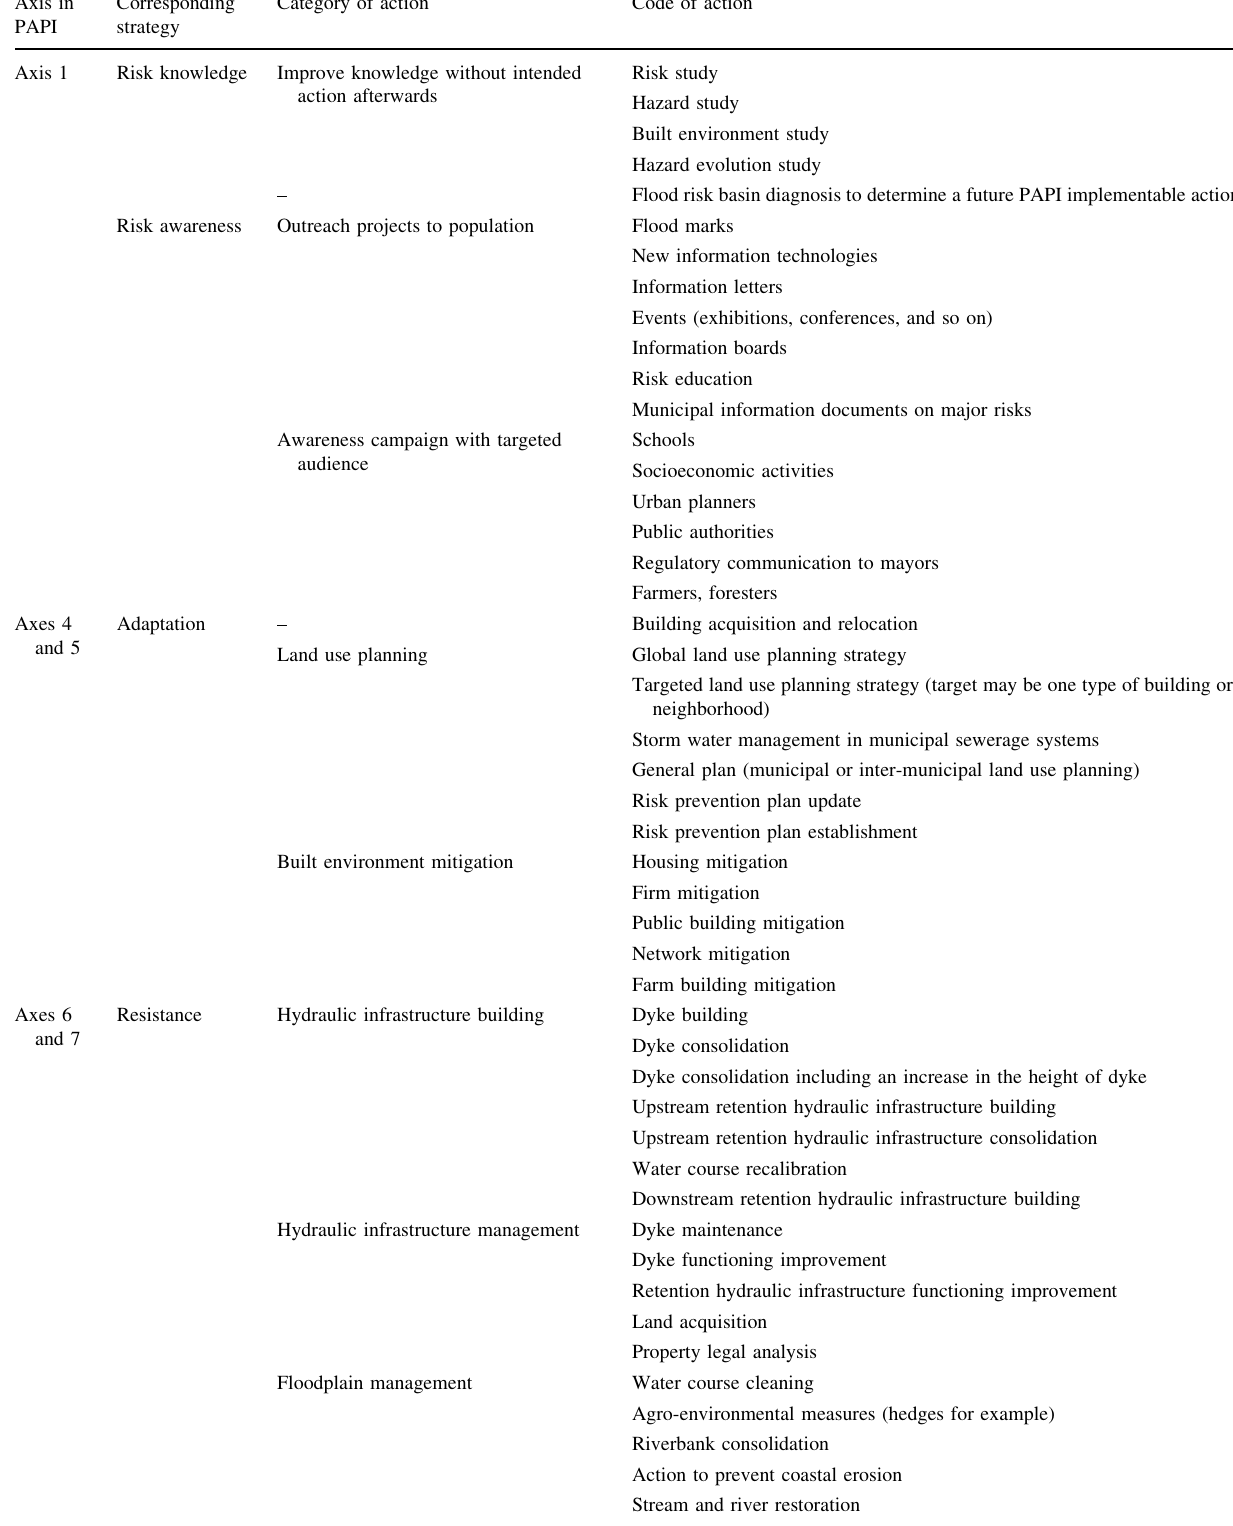
Table 1 Eighty-eight (88) codes used to construct the PAPI action database and their main correspondence with the PAPI axes and strategies. Source : Guillier (2017) Axis in Corresponding PAPI